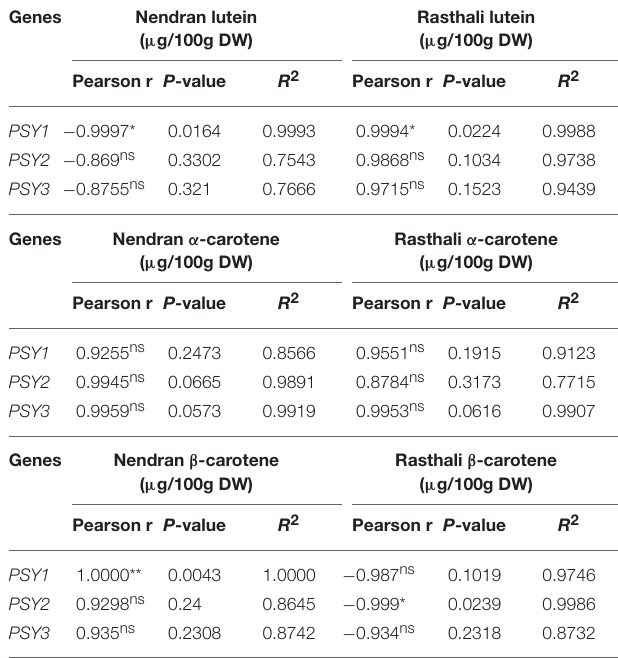
TABLE 3 | Correlation of PSY expression with the accumulation of individual carotenoids in fruit-peel of Nendran and Rasthali. Rasthali lutein ( µ g/100g DW)